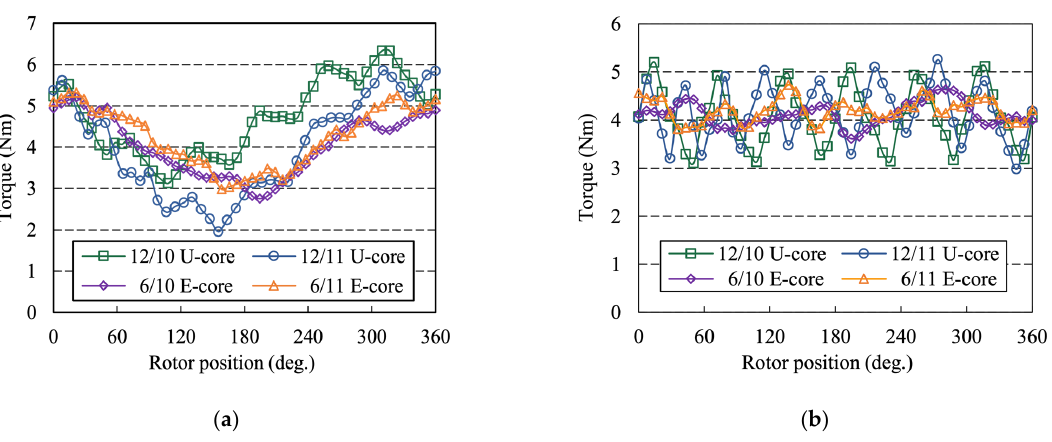
Figure 18. Electromagnetic torque under case II (phase A1, B2 open) and fault-tolerant control condition of four candidates. ( a ) Case II (phase A1, B2 open-circuit); ( b ) fault-tolerant control.